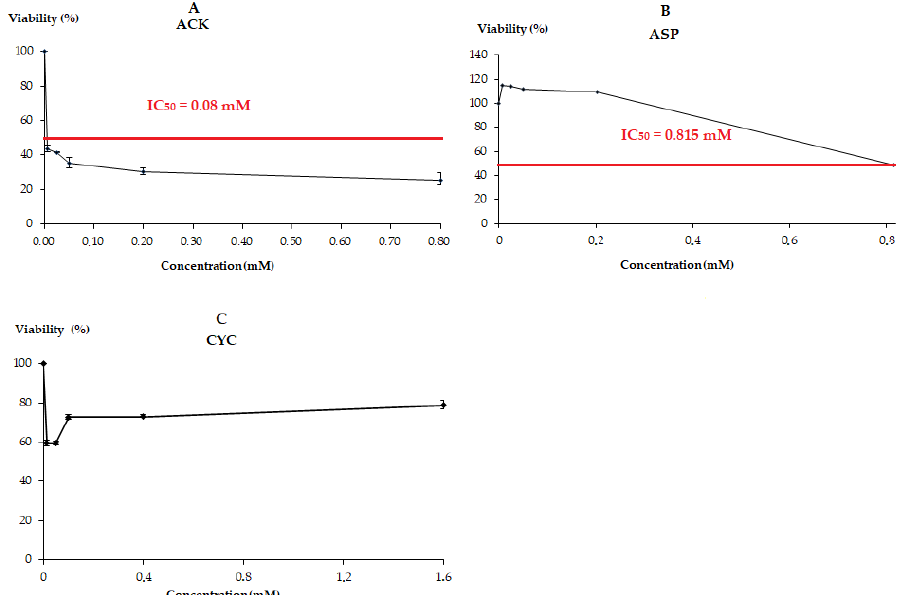
Figure 2. Cytotoxic effects of ACK ( A ), ASP ( B ) and CYC ( C ). Viability curves at 72 h of treatment.